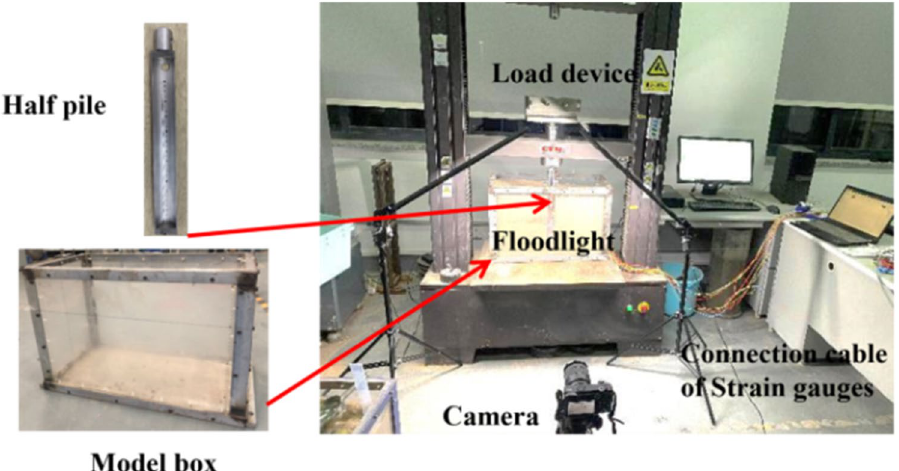
Figure 2. Schematic of test